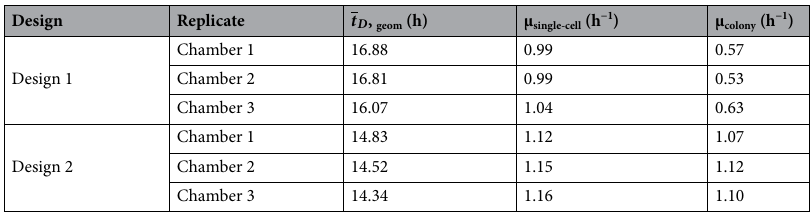
Table 2. Comparison of the single-cell growth rate data µ single-cell , calculated from the geometrical mean of the determined single-cell doubling times t D , with the colony growth rate data µ colony , determined graphically based on the cell